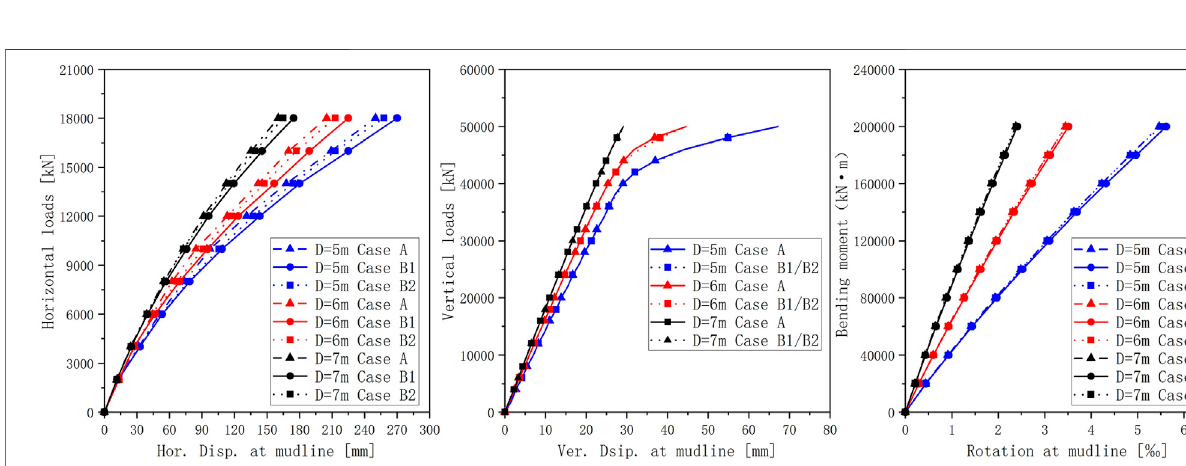
FIGURE 5 | Schematic descriptions of diagonal and horizontal loadings.